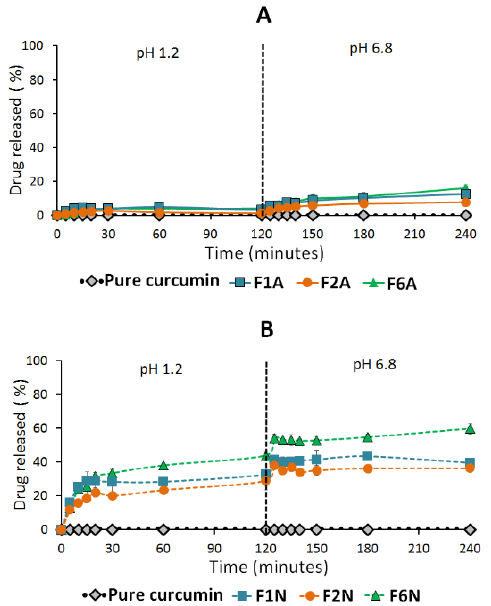
Figure 10. Influence of formulation type and pH on curcumin release from solid SNEDDS. ( A ) Denotes A-300 and ( B ) NUS solidified SNEDDS. The dashed line indicates the time point at which the dissolution media was shifted from pH 1.2 to pH 6.8. Data are expressed as mean ± SD. Details of the formulation compositions are presented in Table 6.